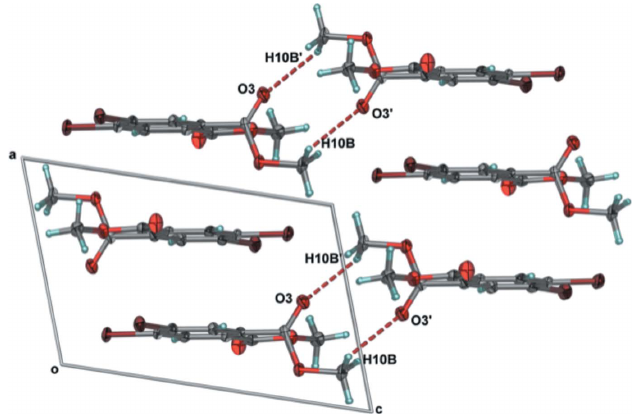
Figure 4 Projection of 1 within the ac -plane showing the formation of the R 2 centrosymmetric dimer facilitated by weak C—H (cid:4)(cid:4)(cid:4) O interactions between layers. Anisotropic displacement ellipsoids have been set to the 50% probability level. Dashed lines represent the C—H (cid:4)(cid:4)(cid:4) O